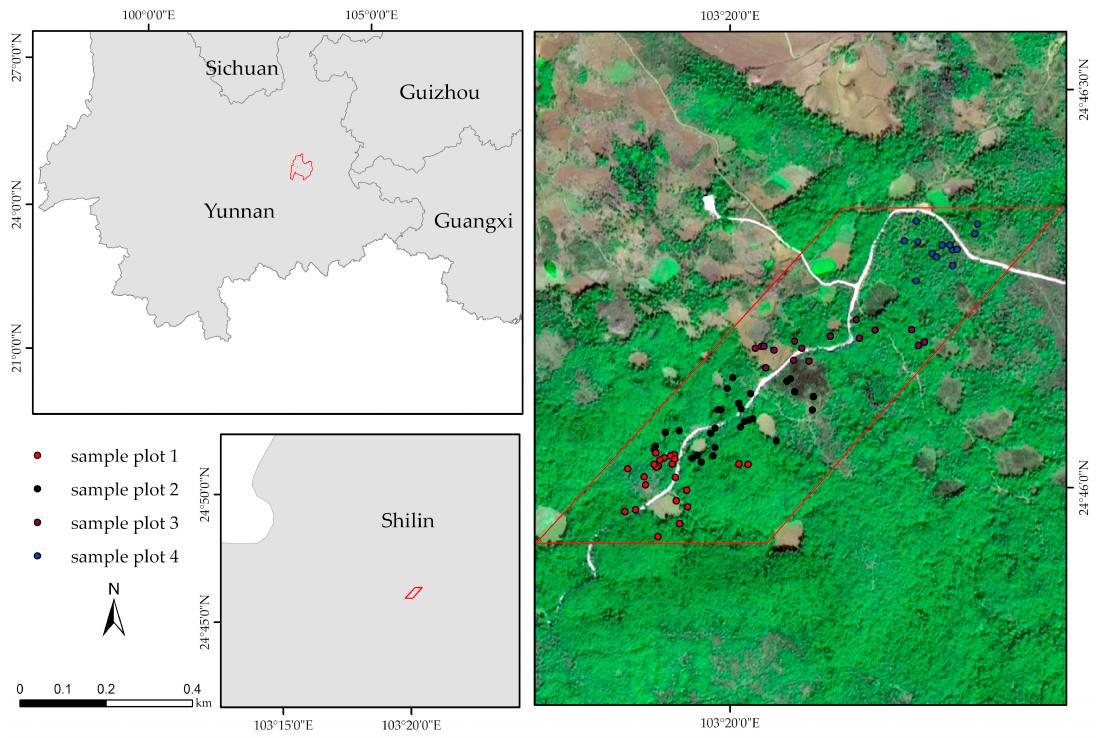
Figure 1. Location of the study area near the reservoir of Heilongtan in Shilin County, Yunnan Province, China. Four sample plots were set up in the study area with randomly selected samples from each plot for a total of 80 sample trees (sample plot 1: 23 trees, sample plot 2: 28 trees, sample plot 3: 16 trees, and sample plot 4: 13 trees). Table 1. The damage degree of individual Yunnan pine caused by the pine shoot beetle (PSB).